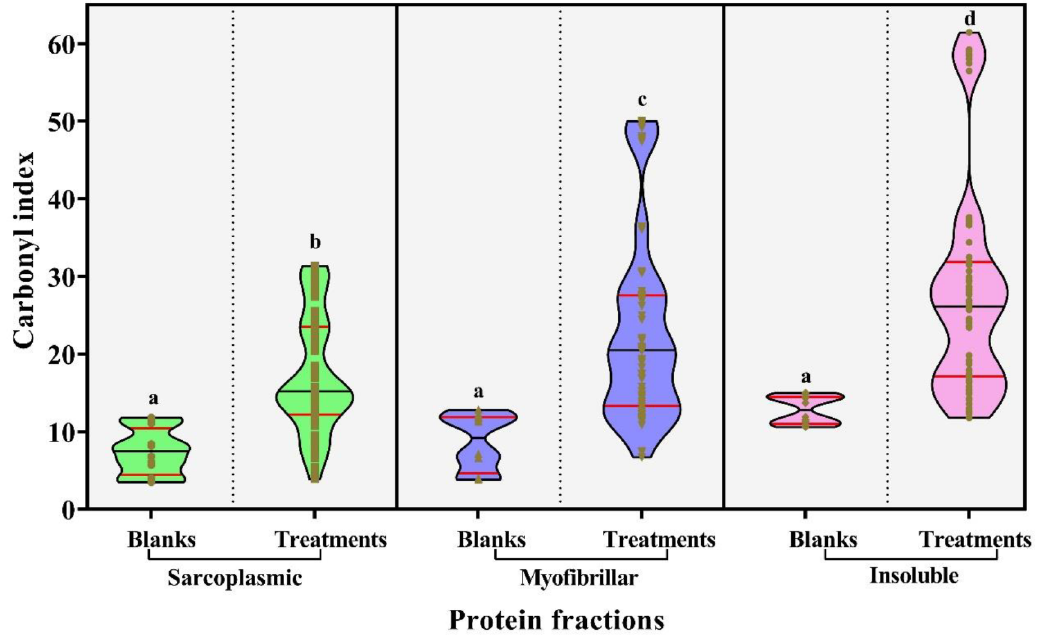
Figure 1. Carbonylation induced by assayed antibiotics (TCs and β -Lts) on main chicken breast proteins. The colors of the violins allude to the type of protein fraction: Green: sarcoplasmic proteins; Blue: myofibrillar proteins and Purple: insoluble proteins. The medians and quartiles are showed as black and red lines in the violin boxes,